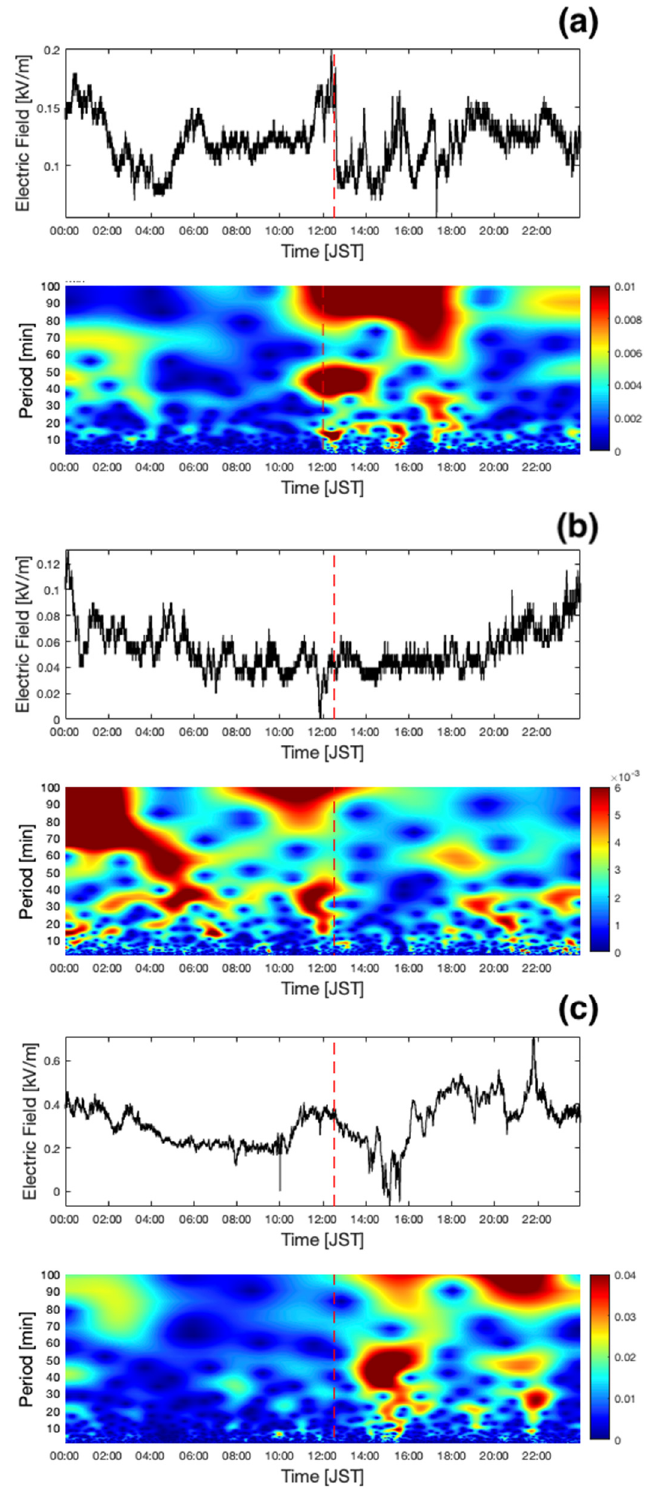
Figure 9. Time series and dynamic periodograms of the AEF for the period interval of up to 100 min on the day of EQ2 (24 h): ( a ) Chofu (CHF), ( b ) Kakioka (KAK), and ( c ) Iwaki (IWK).